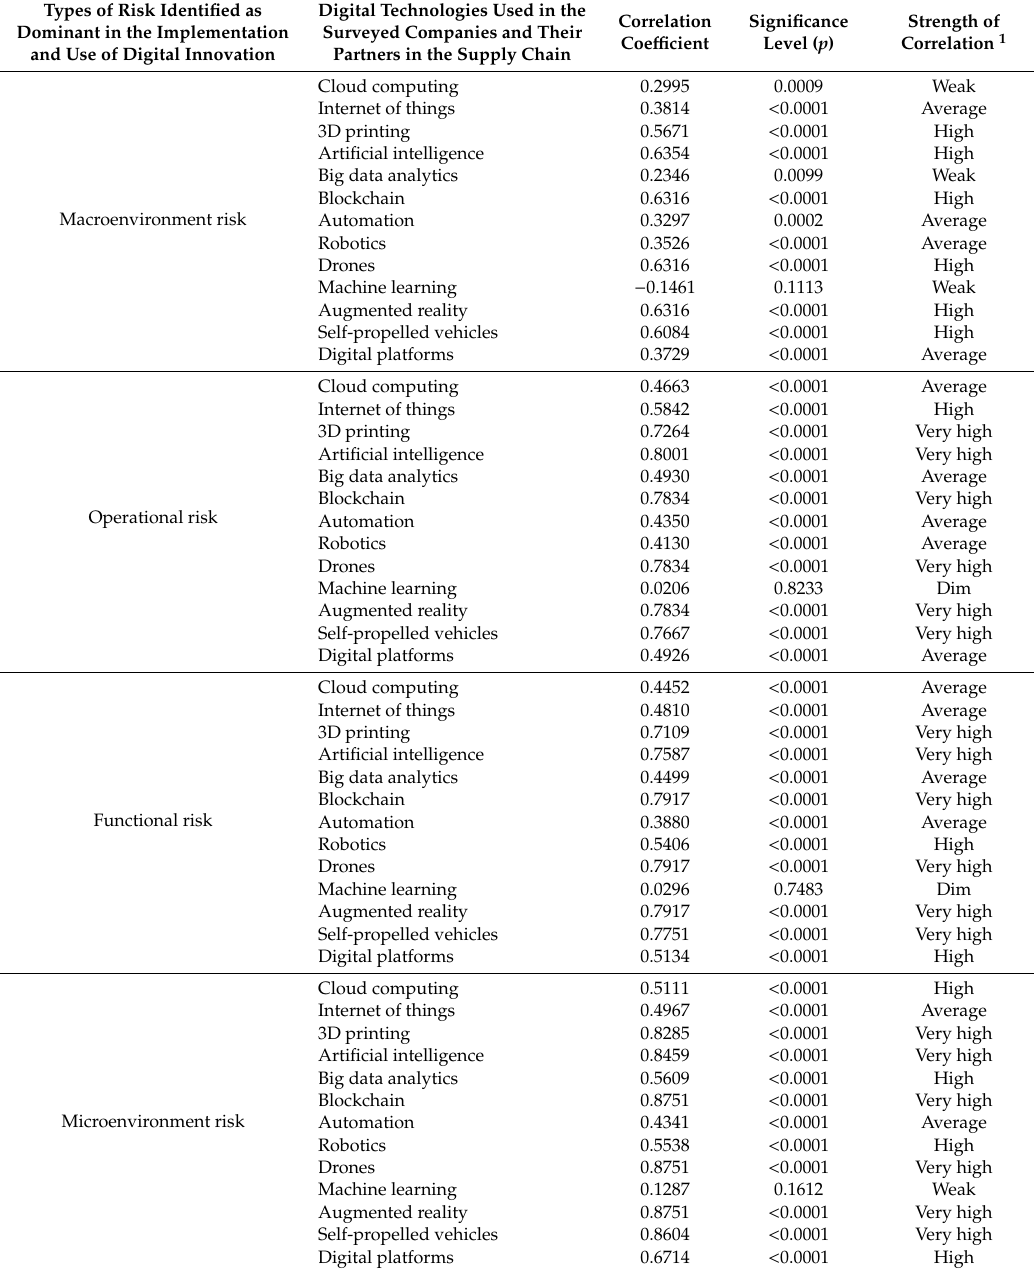
Table 5. Strength of correlation between digital technology and the type of